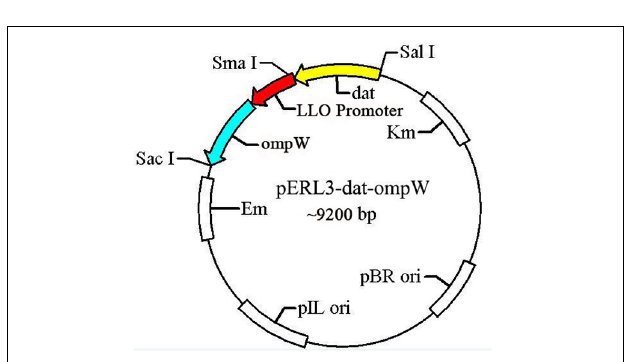
FIGURE 2 | Schematic diagram of recombinant plasmid pERL3-dat-ompW. Listeriolysin O (LLO) promoter sequences of hly and omp W of AH were amplified using primers L1/L2 and W1/W2, respectively. Two fragments were linked using overlap extension PCR, following by insertion at Sal I and Sac I